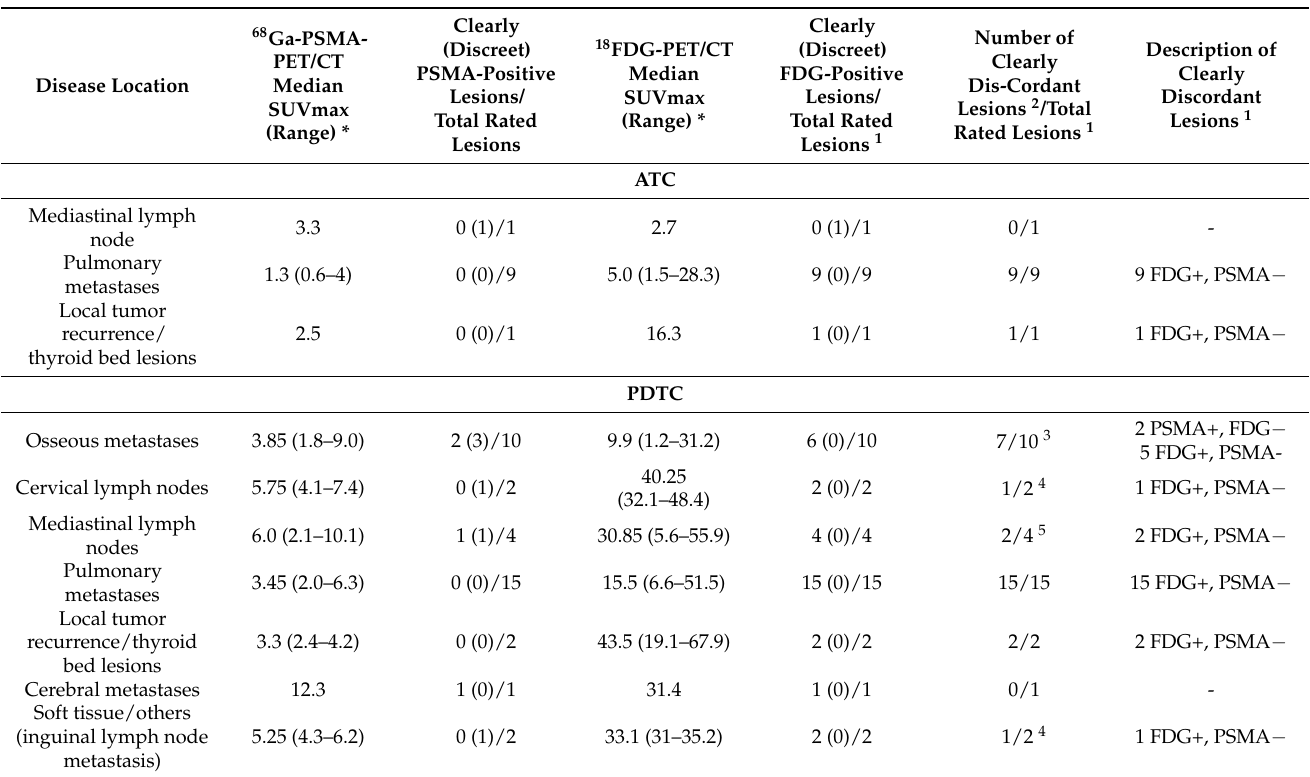
Table 3. Median lesions SUVmax and discordant imaging of metastatic sides of ATC and PDTC on 68 Ga-PSMA- and 18